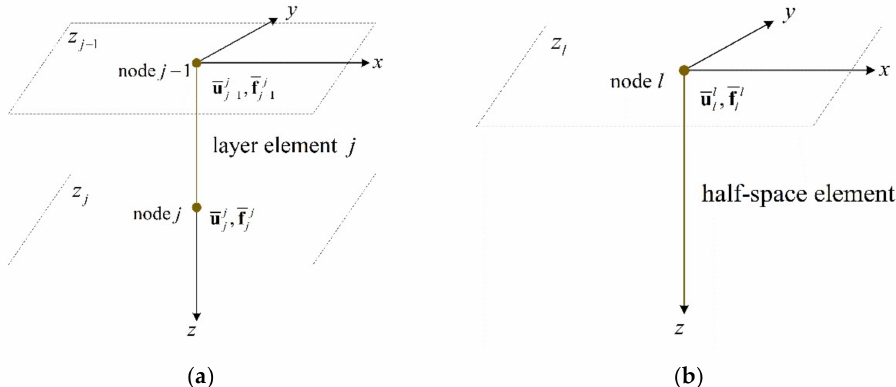
Figure 2. Schematic diagram of spectral elements: ( a ) two-node layer element and ( b ) one-node half-space